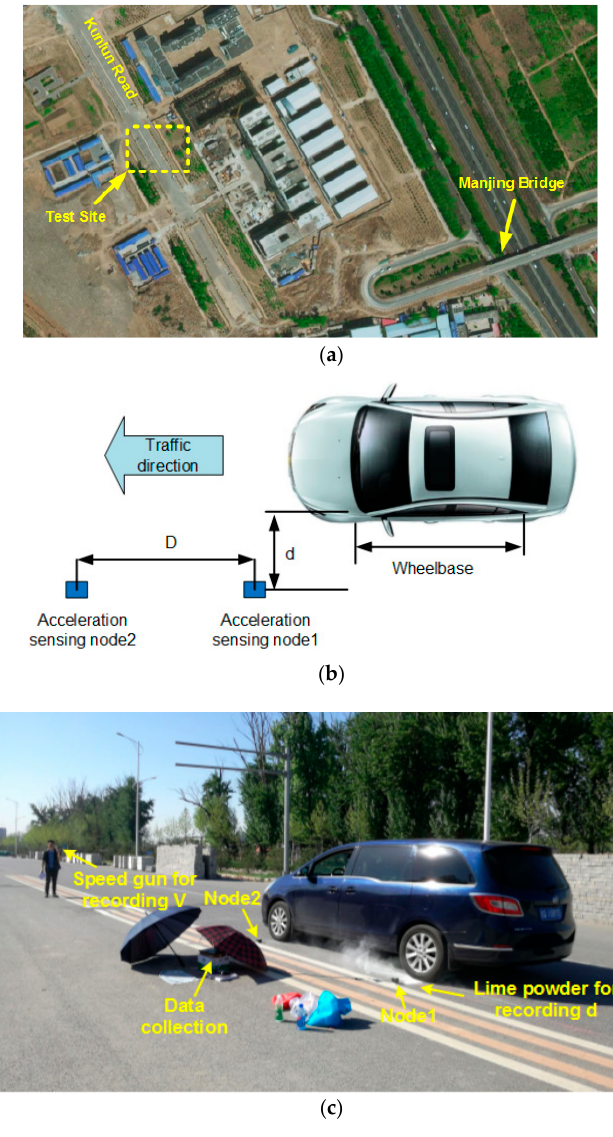
Figure 9. Field experiment. ( a ) Test site; ( b ) Test setup; ( c ) Field test.